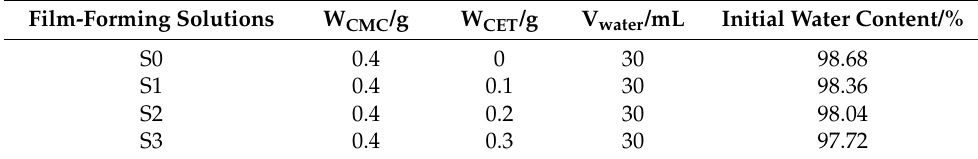
Table 1. Compositions of the different film-forming solutions.